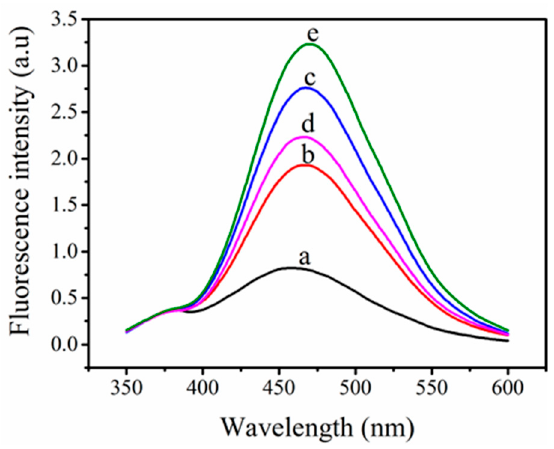
Figure 3. Fluorescence response of the system under different conditions. a: 10 mM Tris-HCL; b: 10 mM Tris-HCL + 10 µ M TPE-2N+; c: 10 mM Tris-HCL + 10 µ M TPE-2N+ + 0.1 µ M ABA; d: 10 mM Tris-HCL + 10 µ M TPE-2N+ + 0.1 µ M Ade; e: 10 mM Tris-HCL + 10 µ M TPE-2N+ + 0.1 µ M ABA + 0.1 µ M